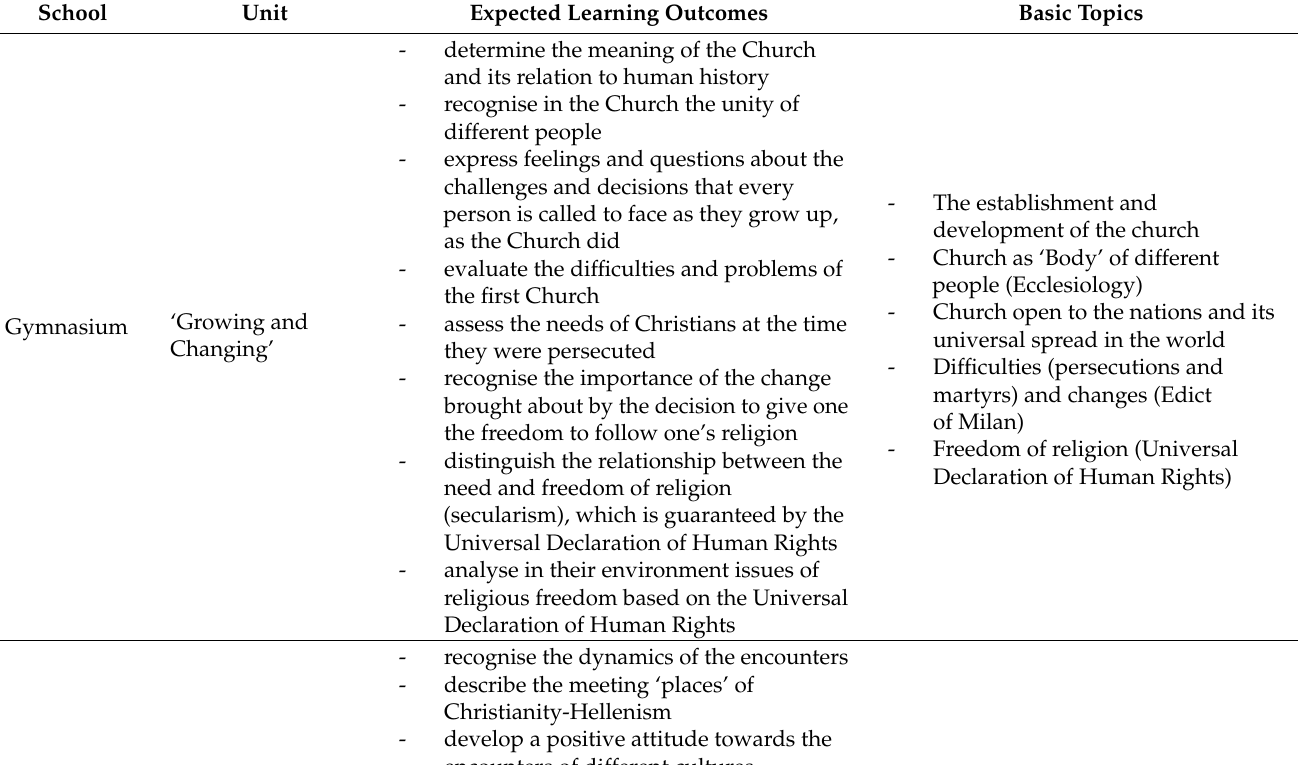
Table 3. Expected learning outcomes and basic topics of the RE